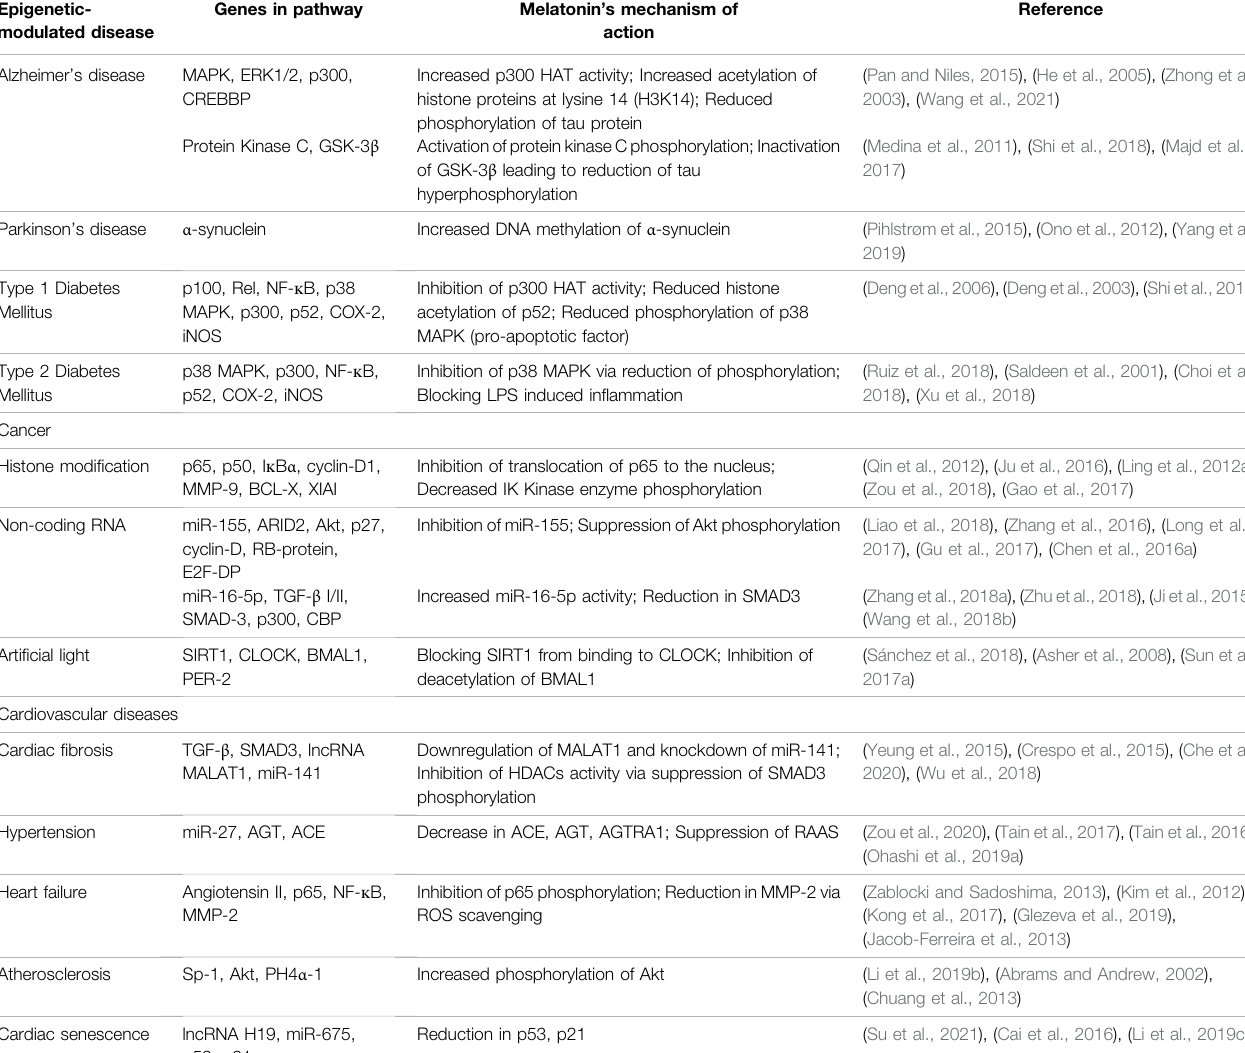
TABLE 1 | Summary of the effects of melatonin on epigenetic-modulated